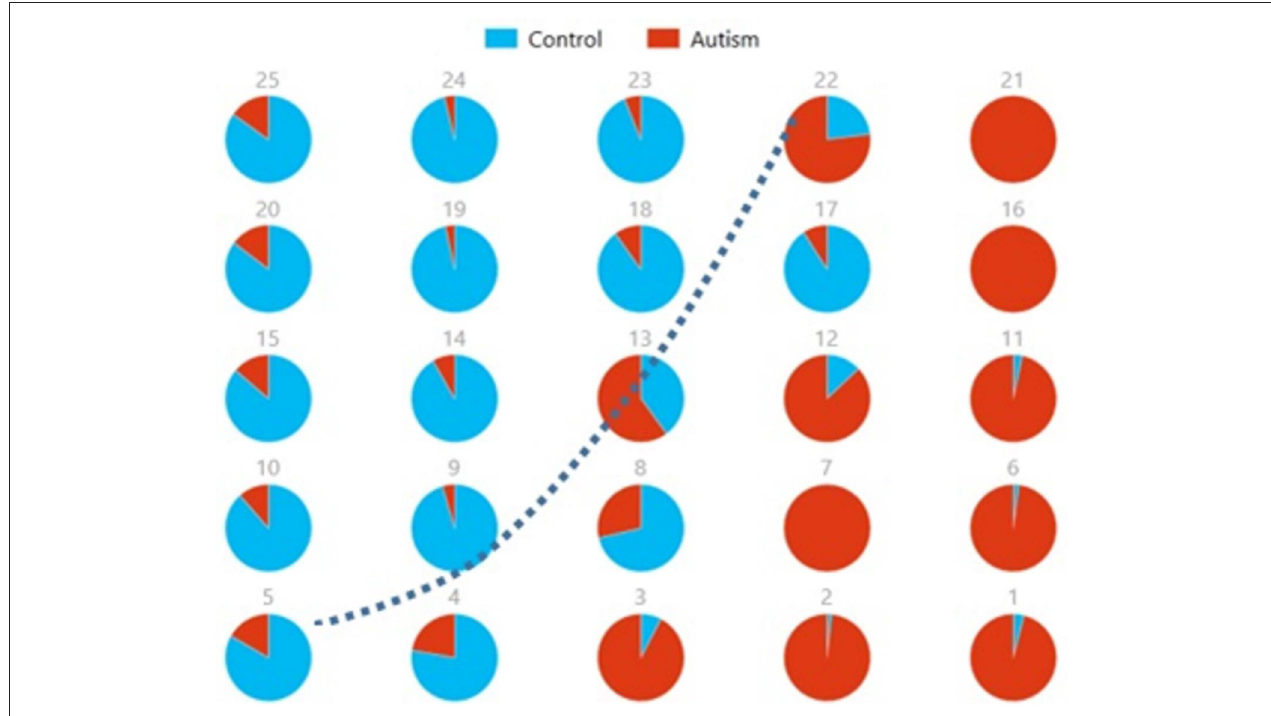
FIGURE 14 | Pie chart visualizations based on a 5 × 5 SOM for A x c and C x showing Autism and Control groups by neuron where the number on each chart corresponds to a neuron in the SOM. The dotted line represents approximate separation between the two